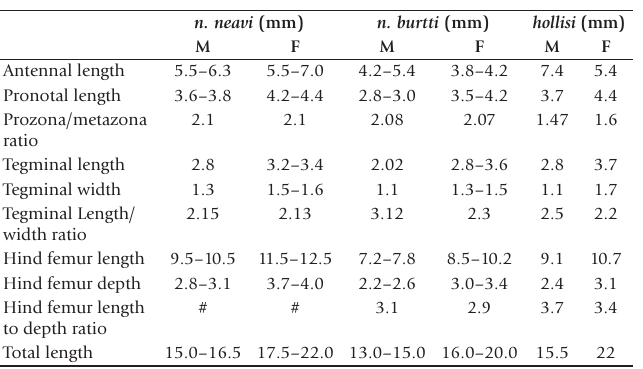
Table 7. Measurements of Anacteana